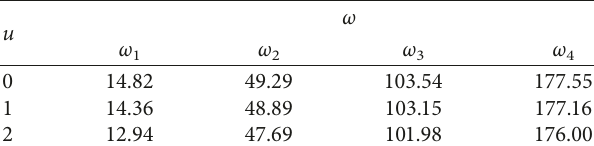
Table 3: The first four orders of dimensionless natural frequencies of the clamped-pinned